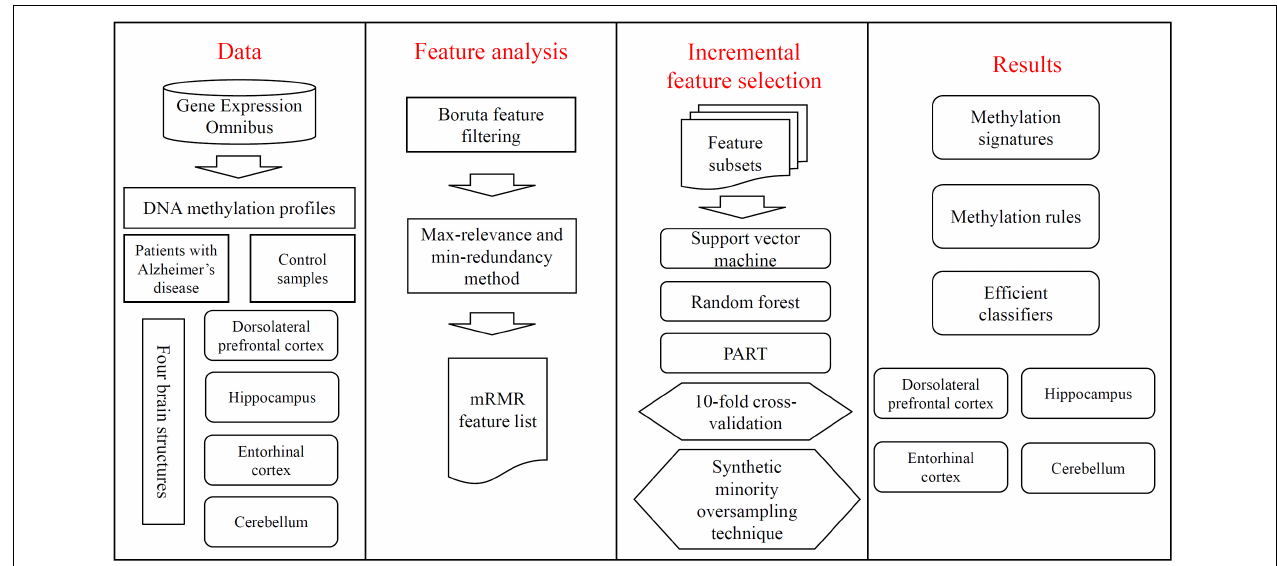
FIGURE 1 | Entire procedures of the investigation on DNA methylation profile of patients with Alzheimer’s disease and control samples. The profile is retrieved from Gene Expression Omnibus. Four datasets are constructed, corresponding to four brain structures. Each dataset is deeply analyzed by Boruta feature filtering and max-relevance and min-redundancy methods one by one, resulting in a feature list. This list is used in the incremental feature selection, containing some classification algorithms, to identify methylation signatures, rules and construct efficient classifiers.